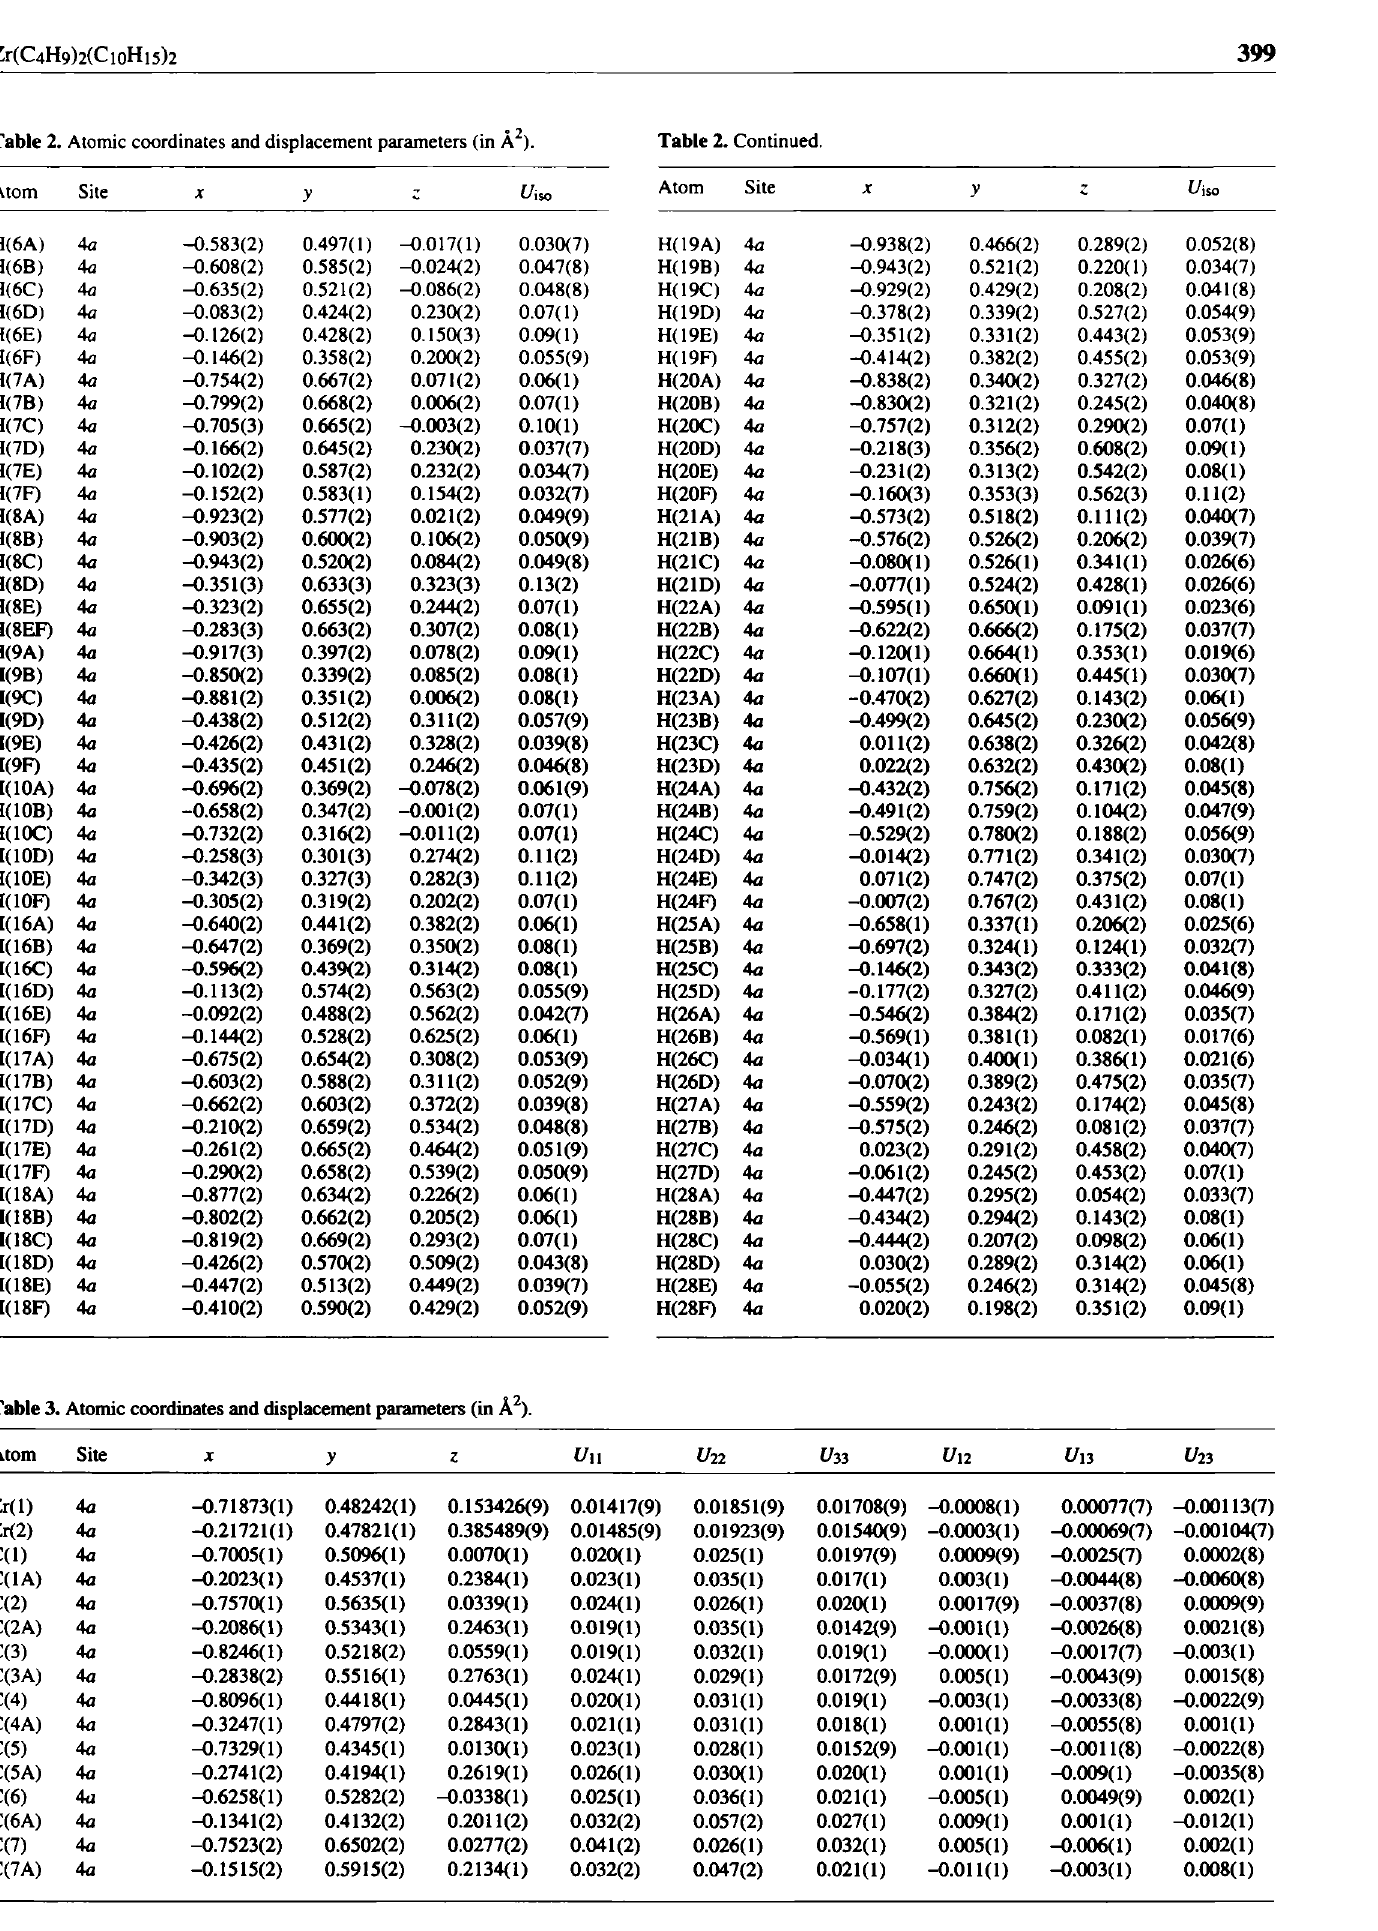
Table 2. Atomic coordinates and displacement parameters (in À ).